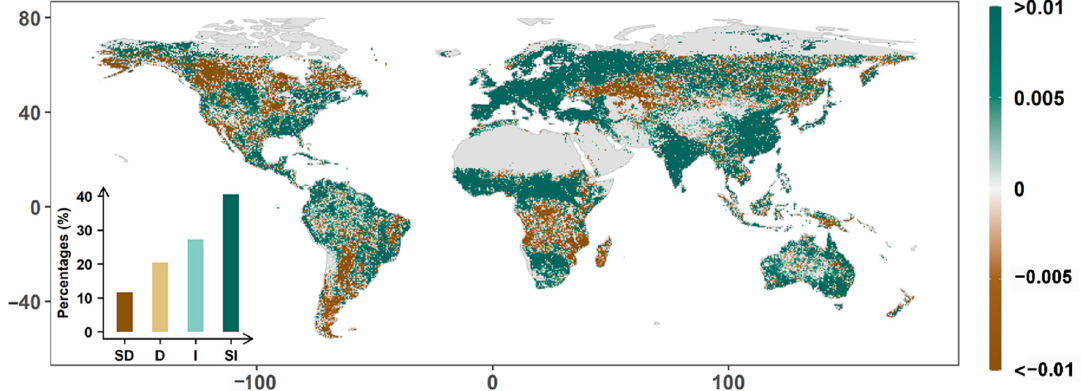
Figure 2. Trends in annual GIMMS NDVI during 1982–2015. The grey color represents the barren areas. Antarctica and Greenland have been removed from the data. The inset histogram shows the percentages of grids showing significant decrease (SD), decrease (D), increase (I), and significant increase (SI).